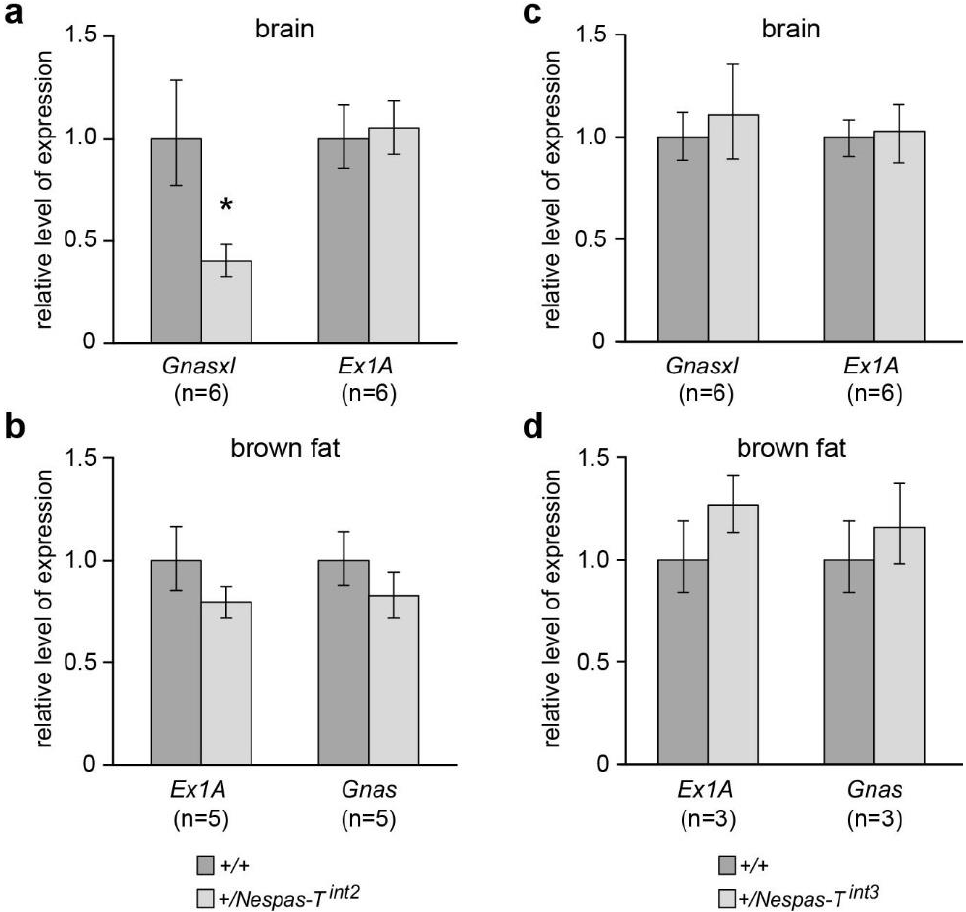
Figure 6. Levels of Gnasxl , Exon1A and Gnas in + / Nespas-T int2 and +/ Nespas-T int3 . ( a ) and ( b ) Gnasxl is downregulated in +/ Nespas-T int2 whereas Exon1A ( Ex1A ) and Gnas are unaffected; ( c ) and ( d ) Gnasxl , Exon1A and Gnas are unaffected in +/ Nespas-T int3 . Gnasxl and Ex1A levels were measured in newborn brain whereas Gnas and Ex1A were analysed in brown fat, a tissue in which Gnas is predominantly expressed from the maternal allele